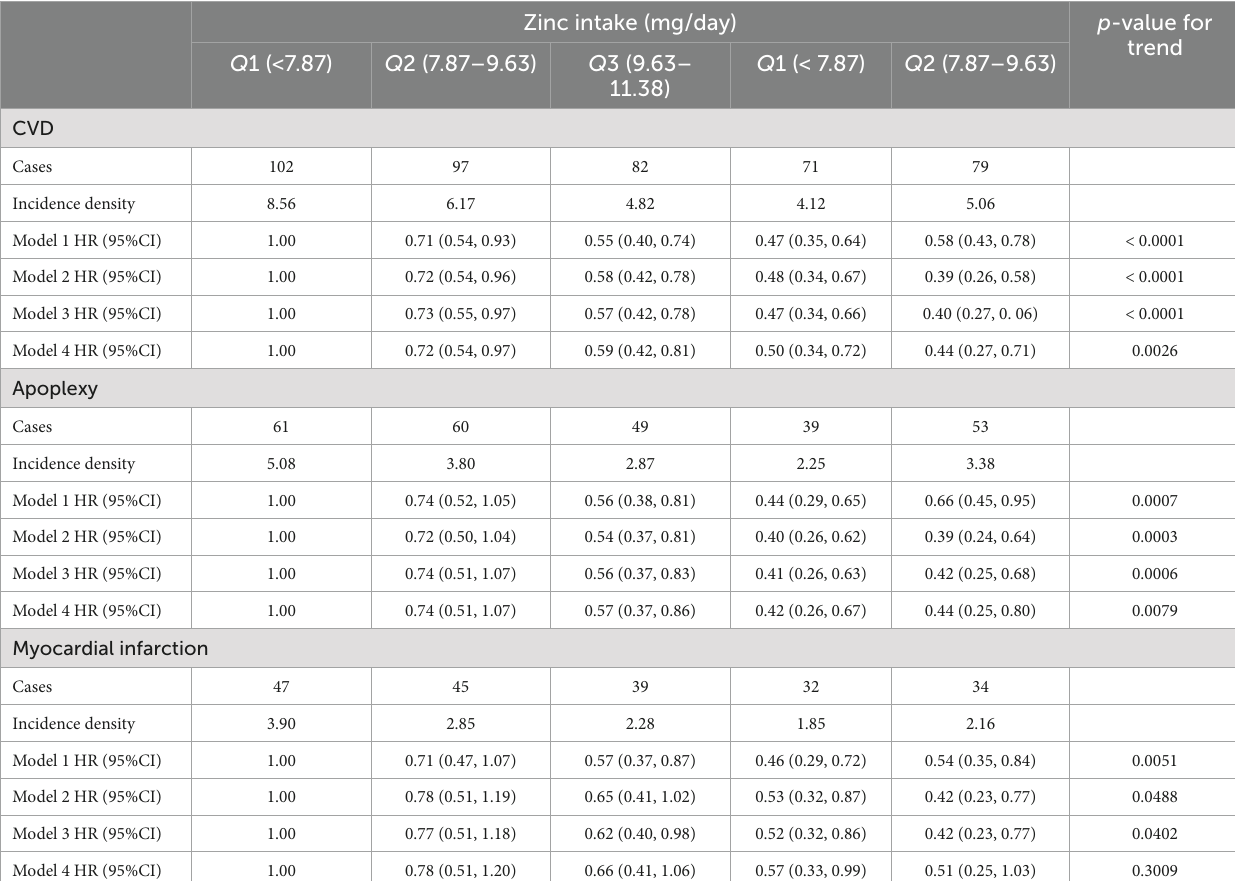
TABLE 3 HR (95% CI) for CVD, apoplexy, and myocardial infarction according to quintiles of dietary zinc intake. Zinc intake (mg/day)